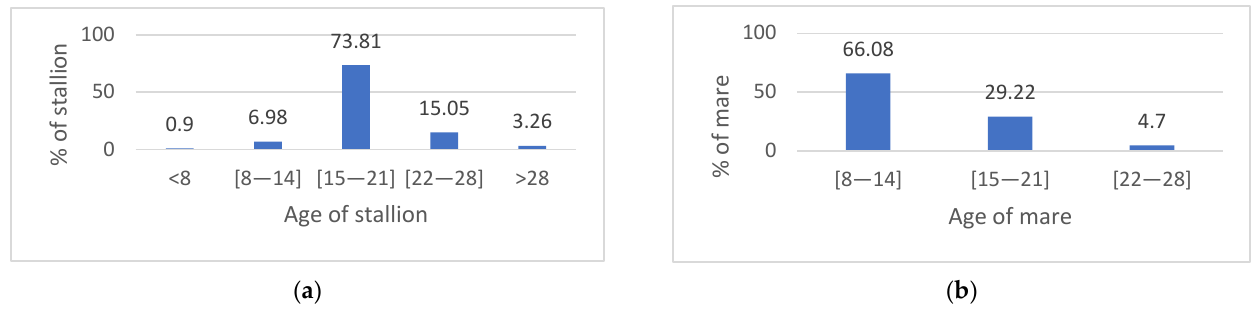
Figure 2. Distribution of stallions ( a ) and mares ( b ) according to their age.